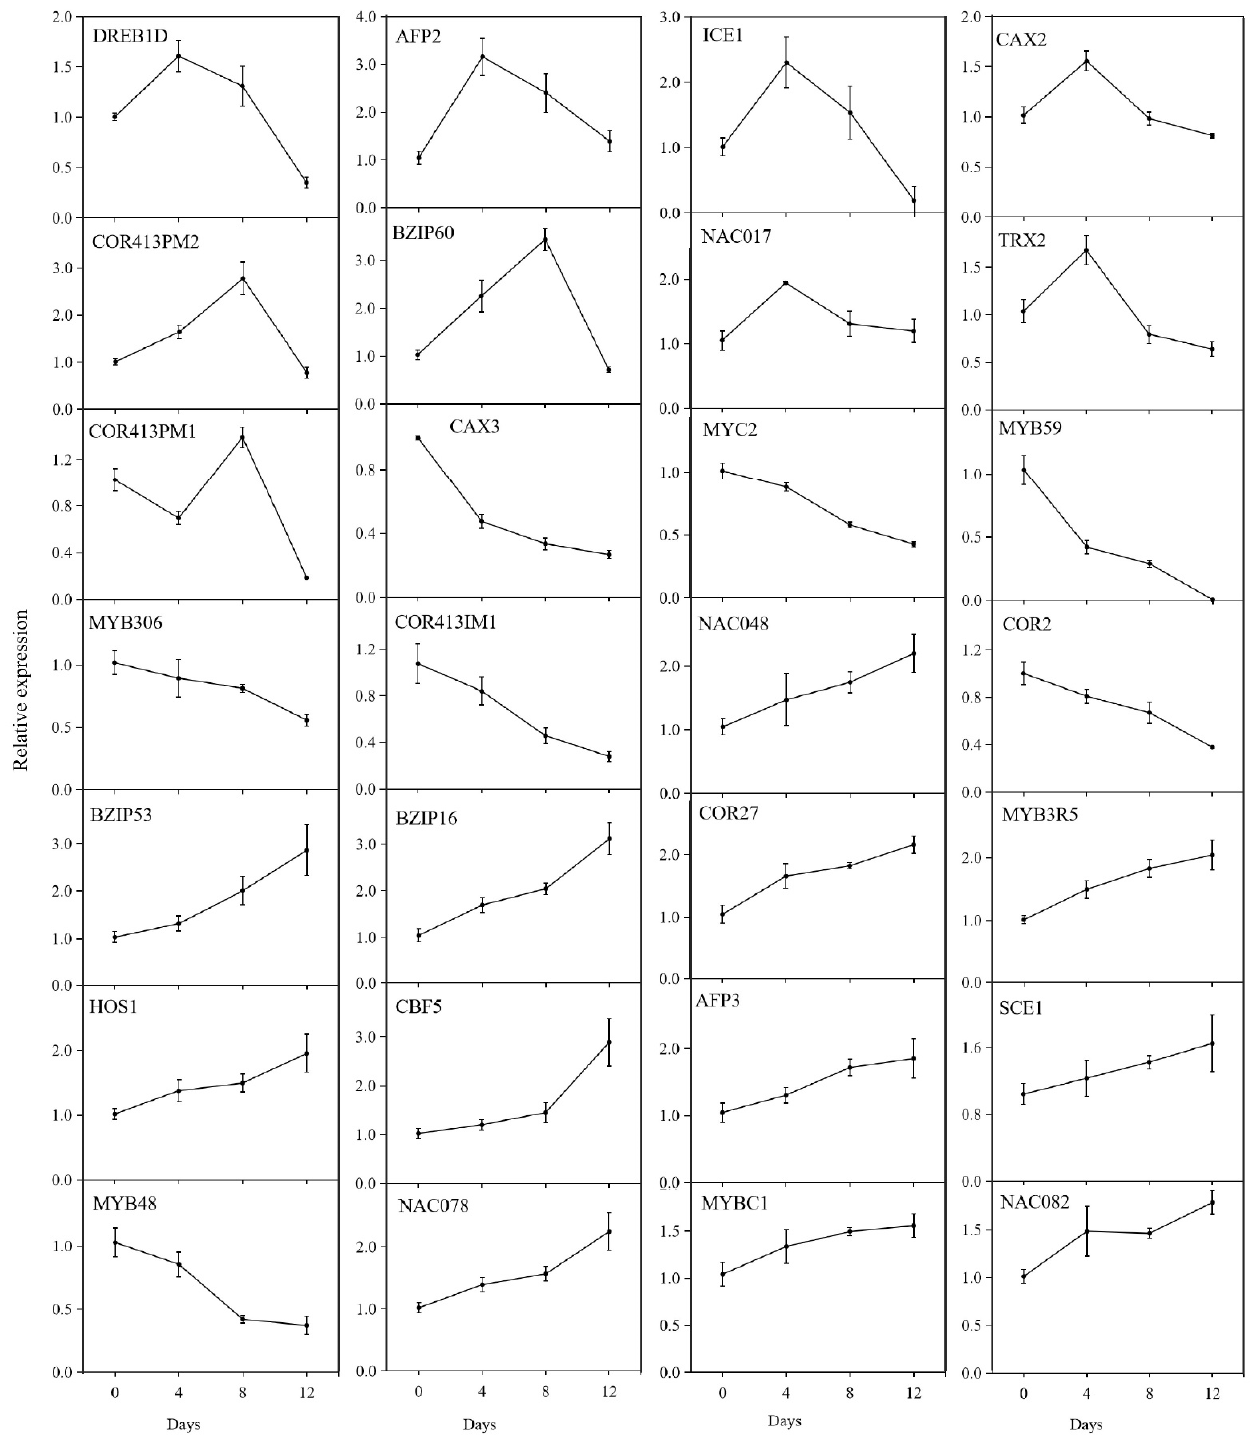
Figure 10. Expression of the 28 differentially expressed genes determined by quantitative real-time PCR. ‘Huaizhi’ litchi trees were grown in a chamber with 22 °C/17 °C (day/night temperature, 12 h day and 12 h night) as the normal temperature. Temperatures dropped from the normal one to 2 °C for 4 d, and then were maintained at 2 °C for another 8 d. C0d, L4d, L8d, and L12d mean the leaves samples at 0 d, 4 d, 8 d, and 12 d of treatment. Relative transcription was calculated by qRT-PCR using the 2 −ΔΔ CT method with actin as a reference.